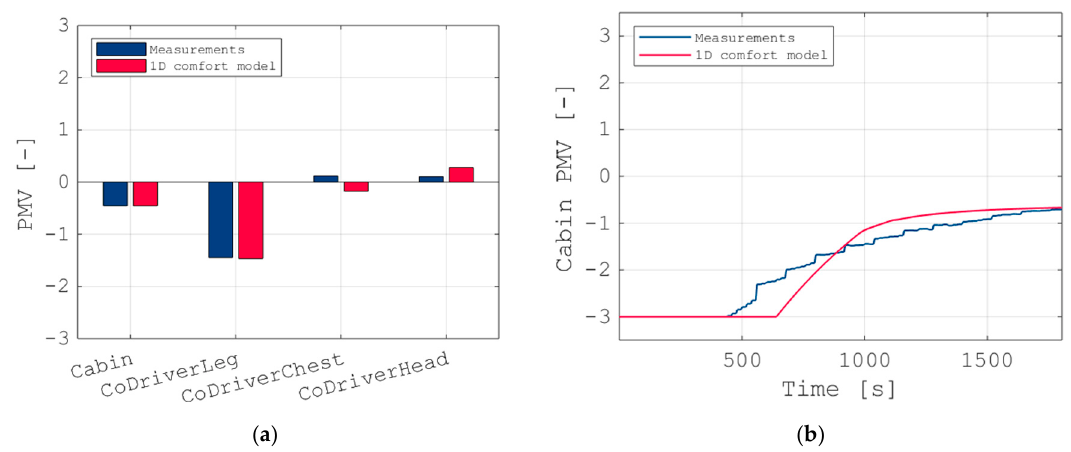
Figure 10. One-dimensional comfort model validation: ( a ) the steady state; and ( b ) transient behaviour.